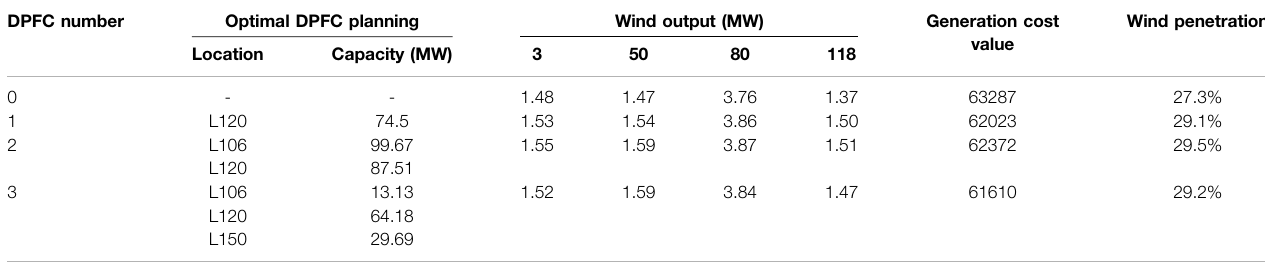
TABLE 4 | Solution of optimal DPFC with variable wind power. DPFC